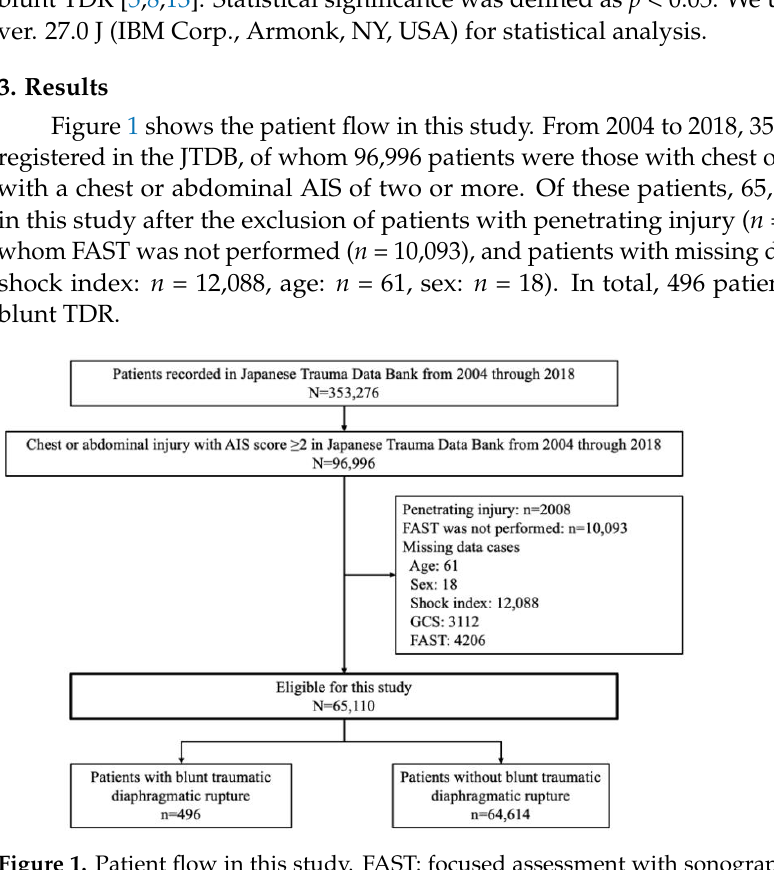
Figure 1. Patient flow in this study. FAST: focused assessment with sonography for trauma; GCS: Glasgow Coma Scale.